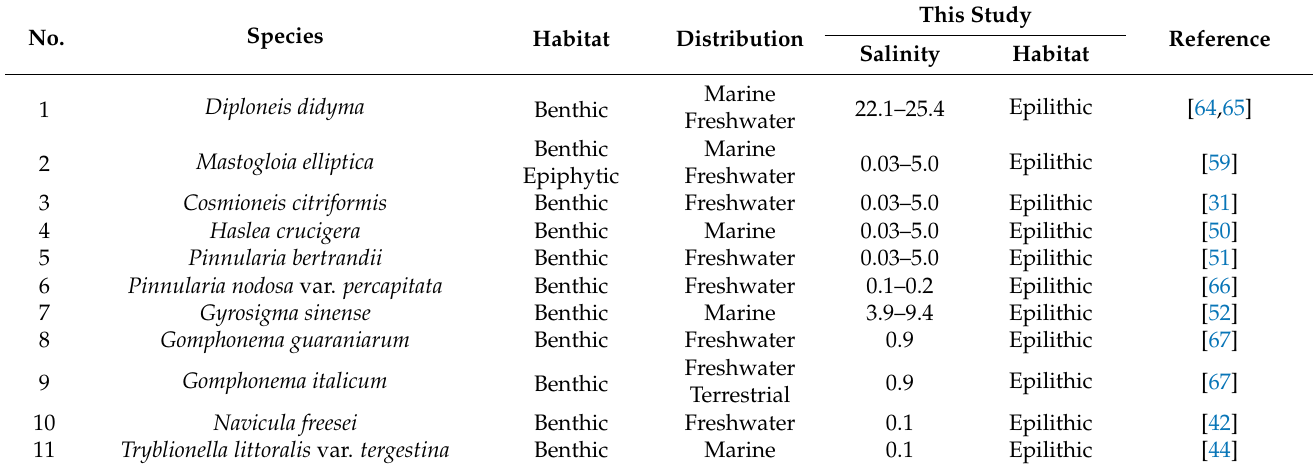
Table 3. Information of New record diatoms in